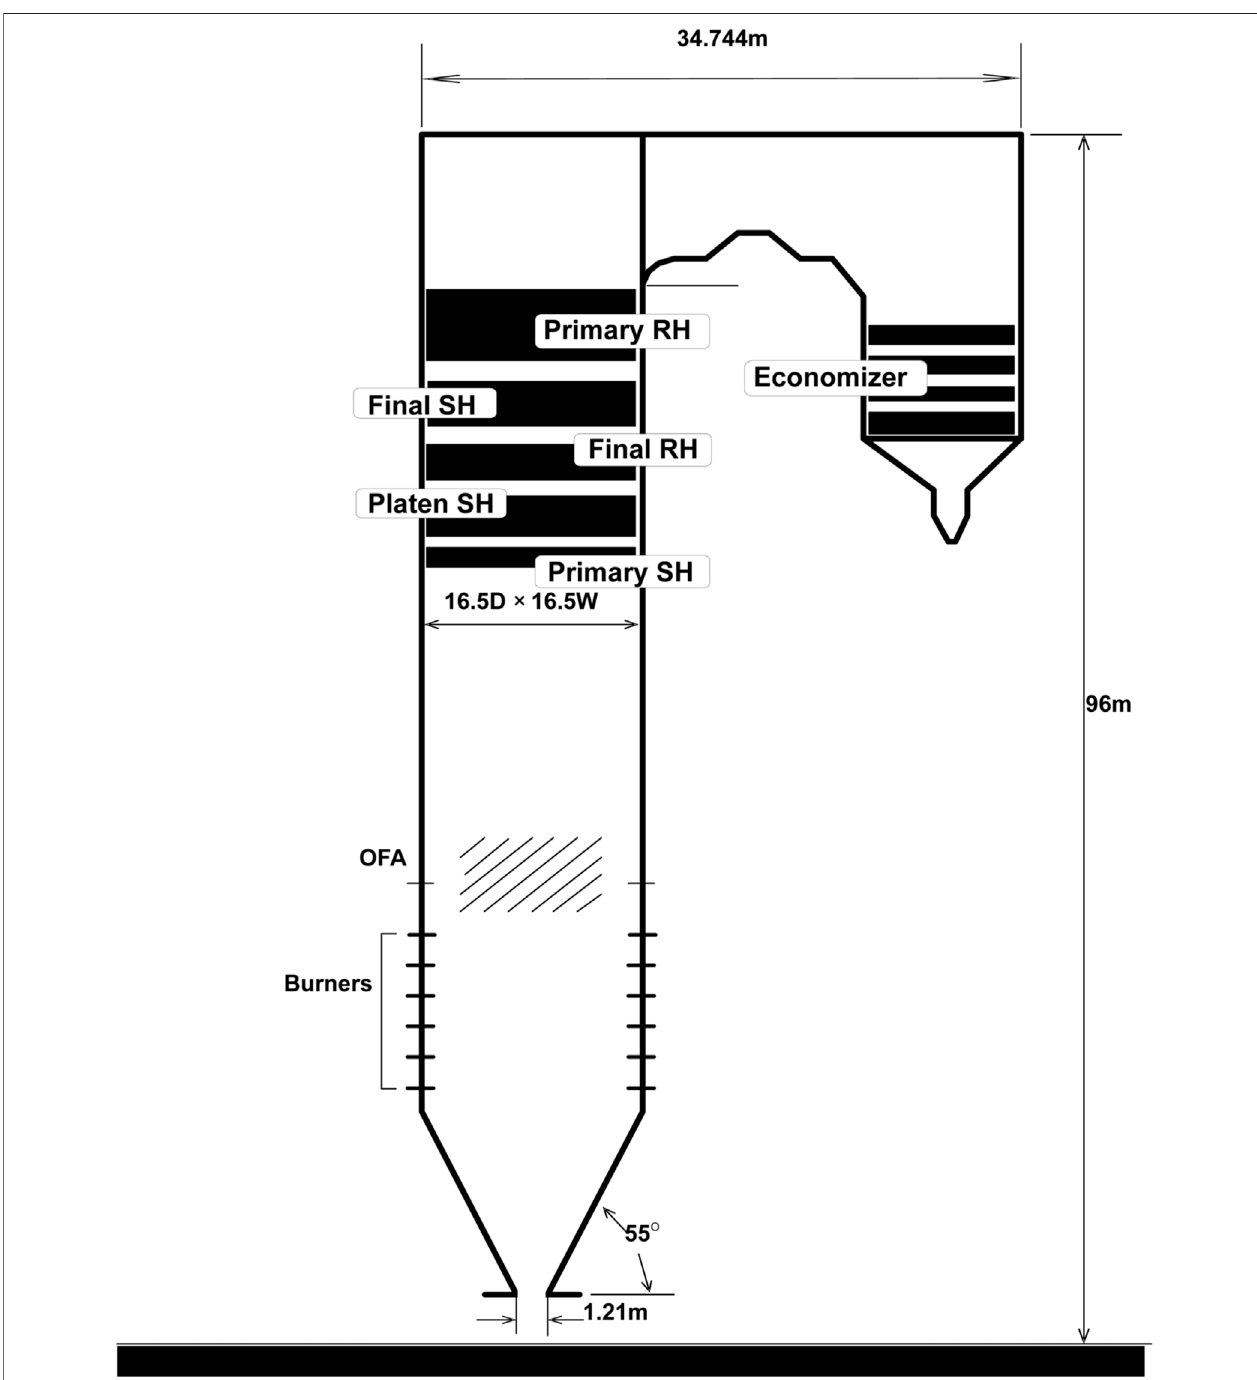
FIGURE 1 | Simpli fi ed schematic of tangentially fi red pulverized coal boiler (Ahmed et al., 2017)